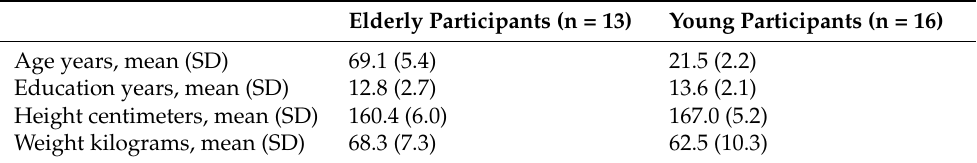
Table 1. The characteristics of